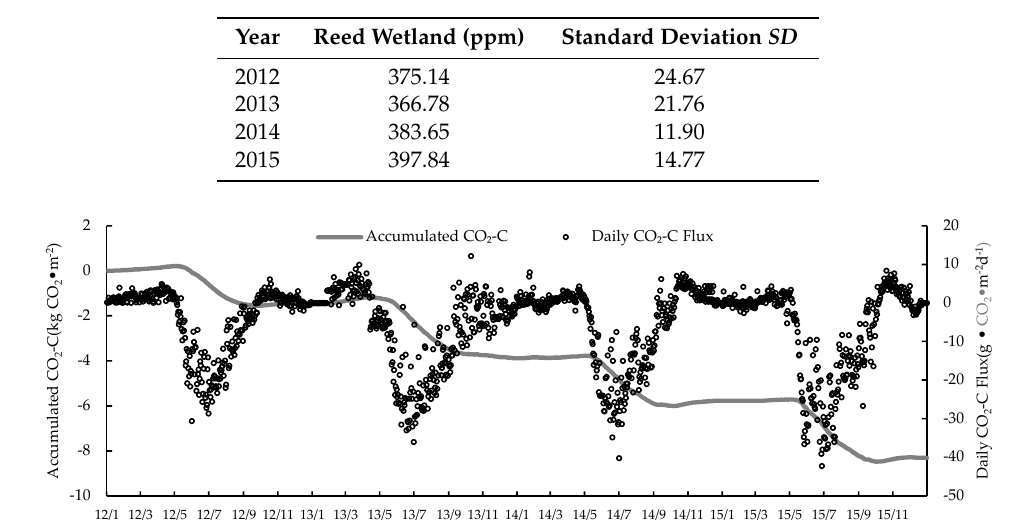
Figure 3. Daily carbon fluxes over the 4-year study period, measured by the eddy covariance technique. Red dots indicate daily sums; and the blue line the accumulated curve.